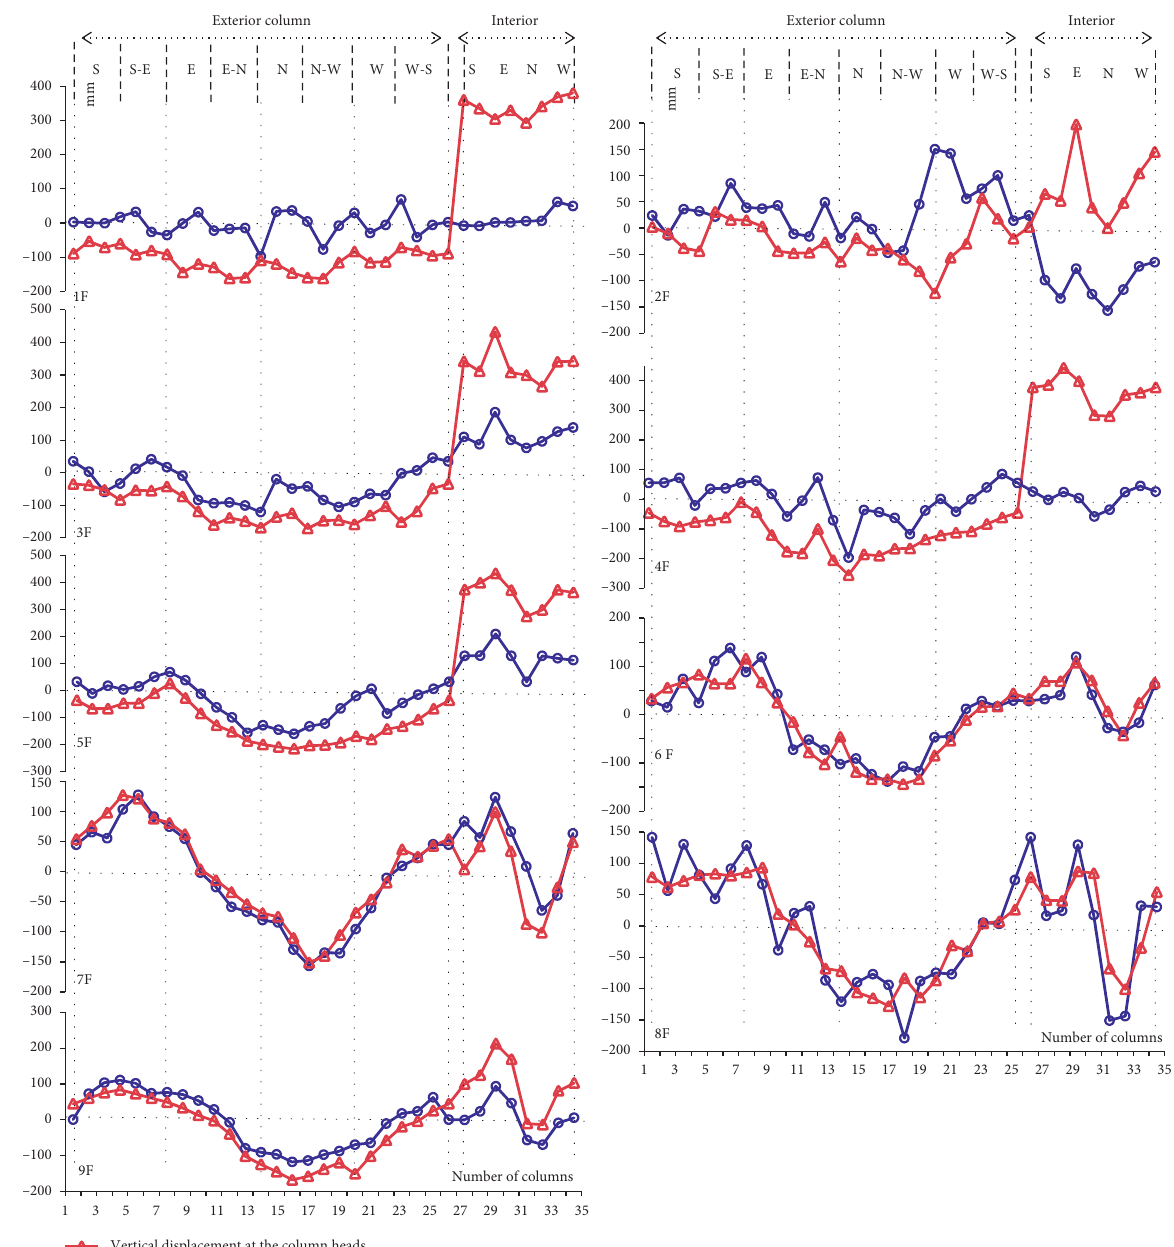
Figure 5: Vertical displacement at the column feet and